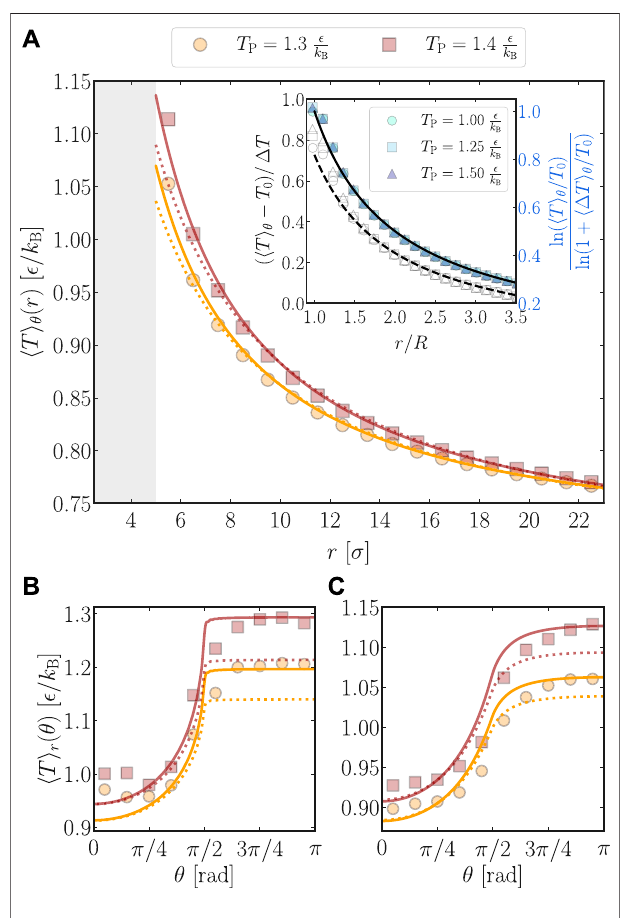
FIGURE 2 | Mean fl uid temperatures extracted from MD simulations (symbols) with wetting parameters c gs (cid:2) 2 and c ps (cid:2) 1 compared to theory (curves). (A) Mean fl uid temperature at radius r averaged over concentric spherical shells of thickness 0 . 1 σ for two different heating temperatures T P of the god cap. The Janus spheres ’ surface is indicated by the gray bar. Using T 0 and Δ T as fi t parameters, theory curves are obtained from Eq. 11 (dotted orange/red), and by θ -averaging the dipole approximation of Eq. 13 (solid orange/red). Inset: Data collapse for three distinct heating powers, characterized by the particle temperatures given in the legend. The reduced temperature fi elds are obtained according to the l.h.s. of Eq. 16 / Eq. 15 using fi t parameters ( T , Δ T ) / ( T , 〈 Δ T 〉 θ ) as obtained in the main plot, open/ fi lled 0 0 symbols referring to the left/right y -axis. Black solid and dashed lines representa R / r and B 0 R / r decay,respectively,with B 0 (cid:2) 1 / 2 + 1 / π , Eq.7 . (B) , (C) Themeasuredradiallyaveraged fl uidtemperatureasafunctionofthepolar angle for two distinct heating temperatures [same as in (A) ], averaged up to a distance of 0 . 1 σ and 2 . 5 σ from the surface, respectively. For the dotted theory curves we radially averaged the fi rst 100 terms of Eq. 6 , while the solid lineswereobtainedfromthe fi rst100termsofthenumericallyaveragedpro fi le in (13) ; parameters T 0 , Δ T as obtained in (A)